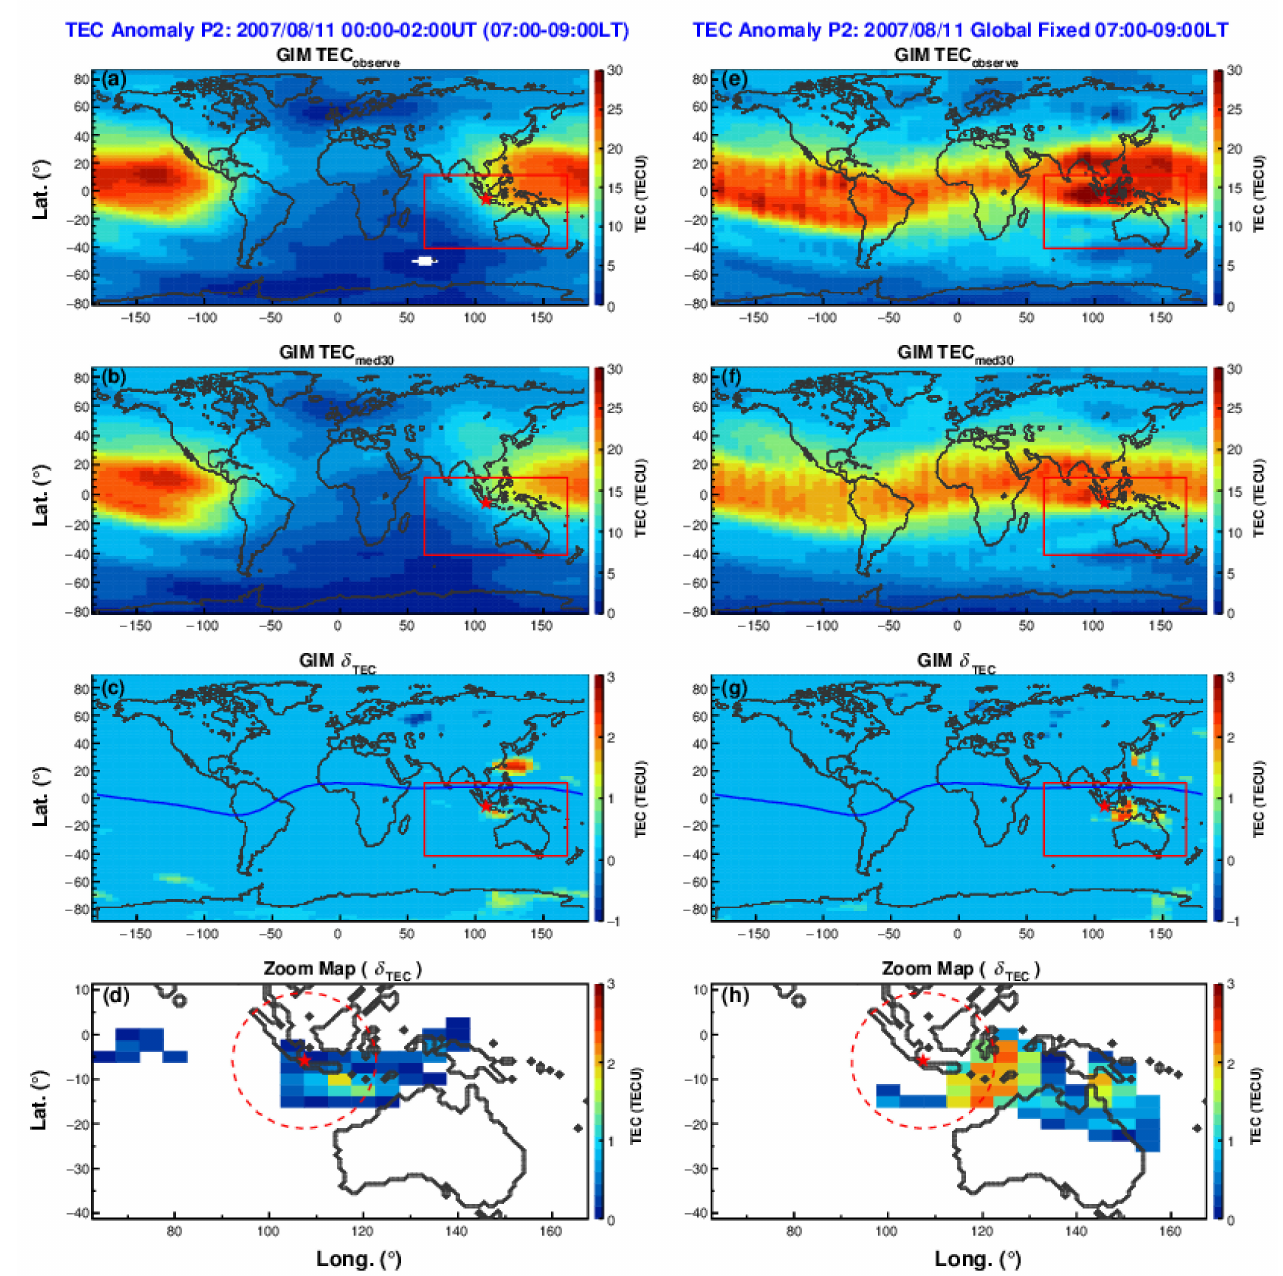
Figure 4. Similar to Figure 3, the spatial deviations in GIM TEC during the temporal anomalies period